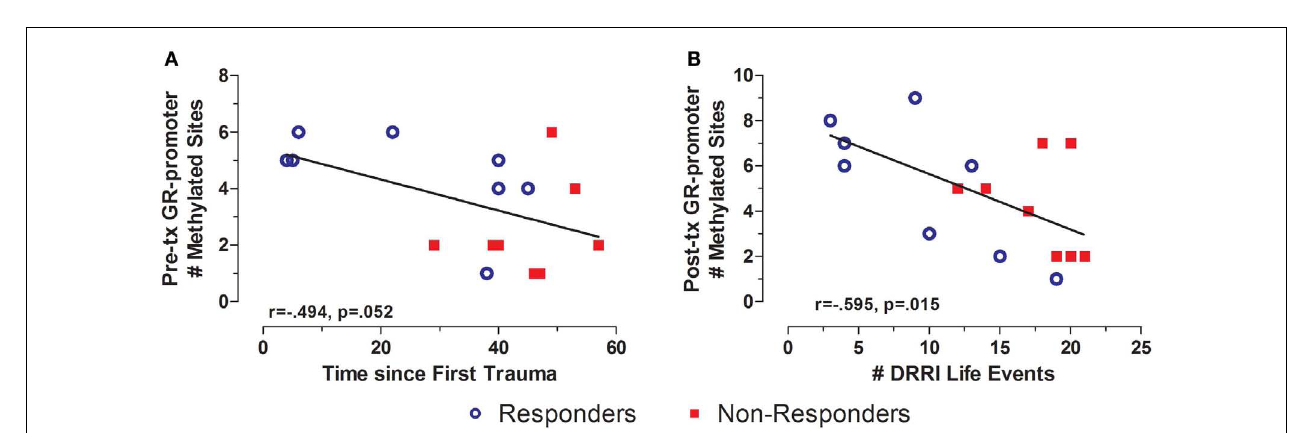
Responders ( n = 8) to treatment are represented by blue, open circles and non-responders ( n = 8) by red squares. Longer time since first trauma and greater number of traumatic life events both associated with lower GR exon 1F promoter methylation, at pre-treatment and post-treatment, respectively. Correlation coefficients are denoted in the different panels. Statistical significance was set at p <